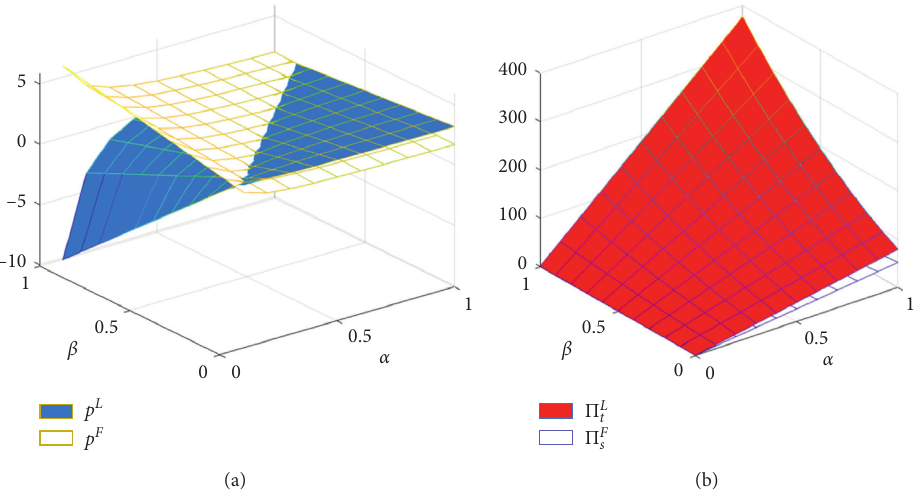
Figure 10: Price strategies and profits comparison. (a) p L and p F (b) Π L